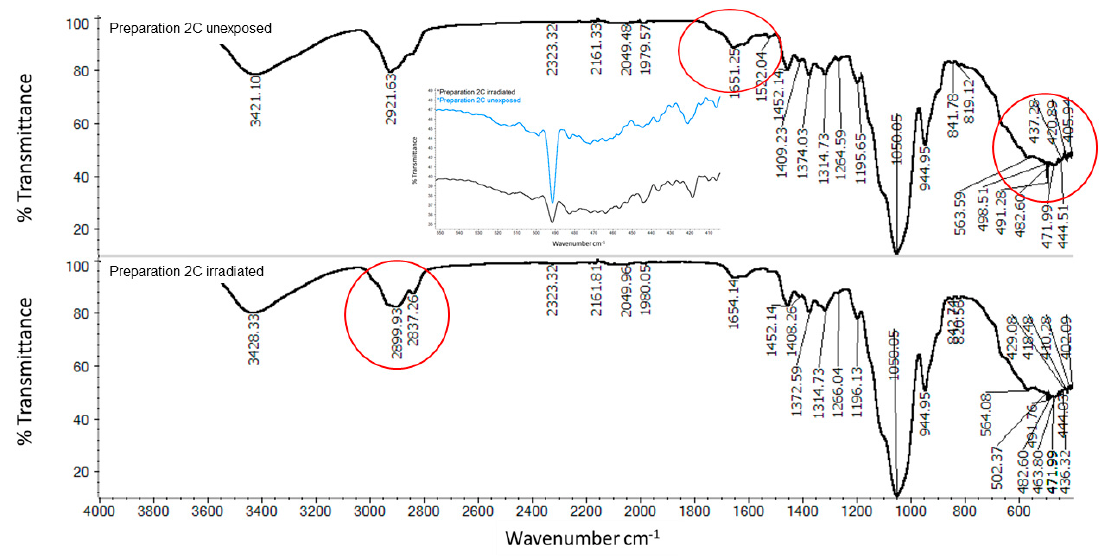
Figure 10. FTIR spectrum of freeze-dried preparation 2C—( A ) unexposed Preparation 2C, ( B ) irradiated Preparation 2C; composition of the Preparation 2C is given in the Table 1. The inset shows the enlarged signal in the spectrum at approximately 491 nm, for unexposed preparation of 2C.